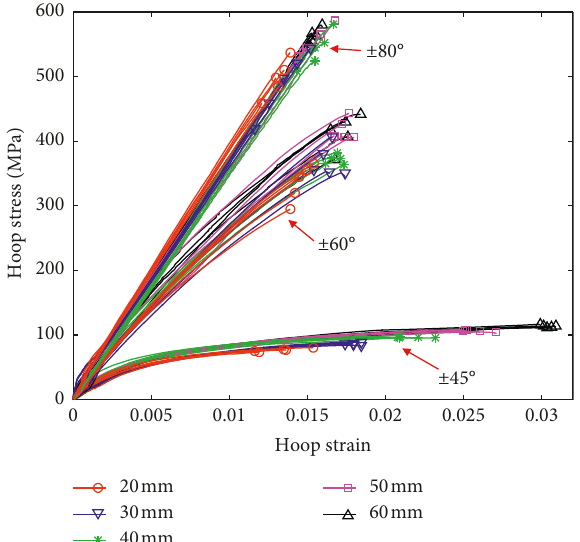
Figure 5: Hoop stress-hoop strain curves of FRP rings.